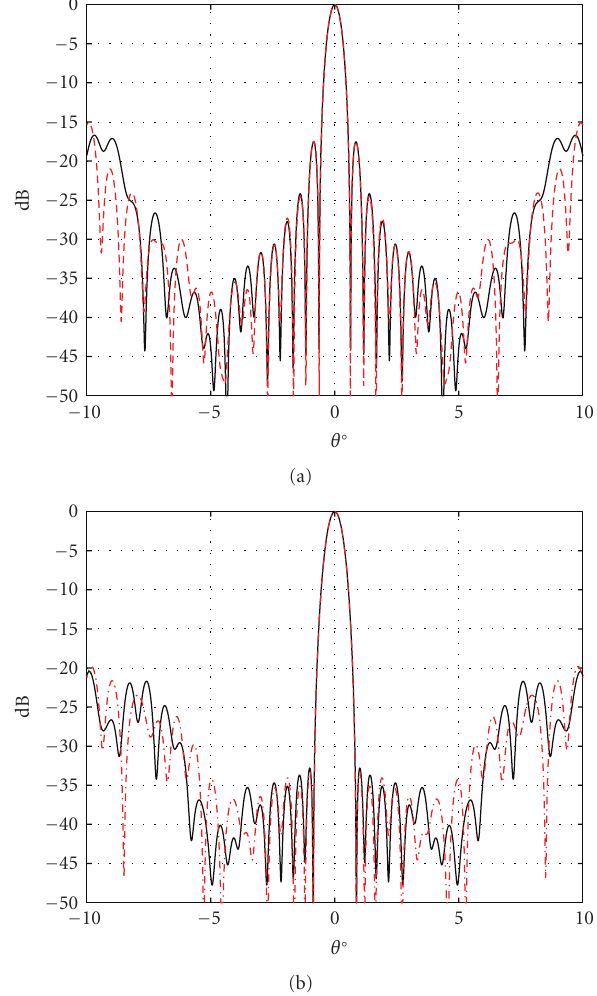
Figure 4: Array Factor, two di ff erent φ cuts ( φ = 0 ◦ in red dotted line and φ = 90 ◦ in black), for the array configuration in Figures 1 and 2, respectively.